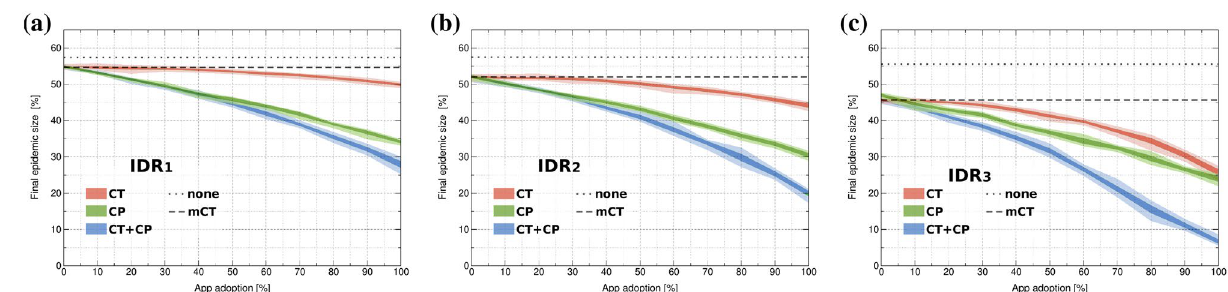
Figure 3. Final epidemic size for CT, CP, and combined CT + CP strategies in three IDR scenarios for varying app adoption percentages. IDR 1 , IDR 2 and IDR 3 correspond to 13%, 26% and 37% overall infections detected. We also plot no strategy (none) or only manual CT (mCT) scenarios as dotted lines for reference. Darker and lighter colored areas show the standard deviation and highest/lowest values obtained from 60 simulations of 1 × 10 5 agents per point. Results correspond to maximum number of direct close contacts C max = 3.1 for CP and a delay of D = 3 days since symptoms onset for